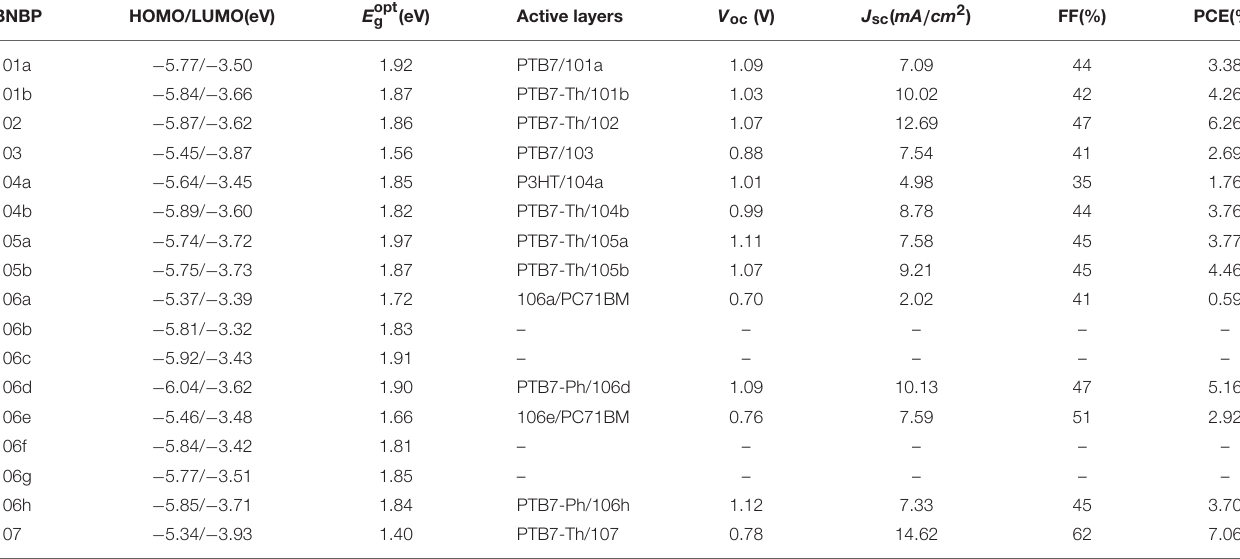
TABLE 3 | Optoelectronic and photovoltaic parameters for BNBP-based materials. BNBP HOMO/LUMO(eV) E opt g (eV) Active layers V oc (V) J sc ( mA / cm 2